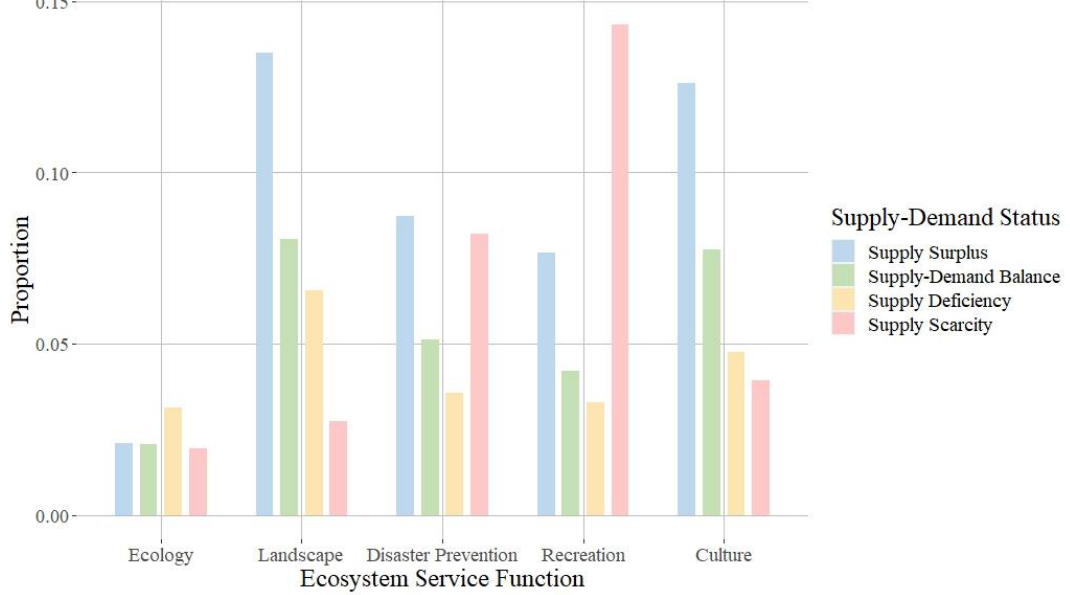
Figure 8. Proportion of five ESFs supply – demand status not reaching supply sufficiency.